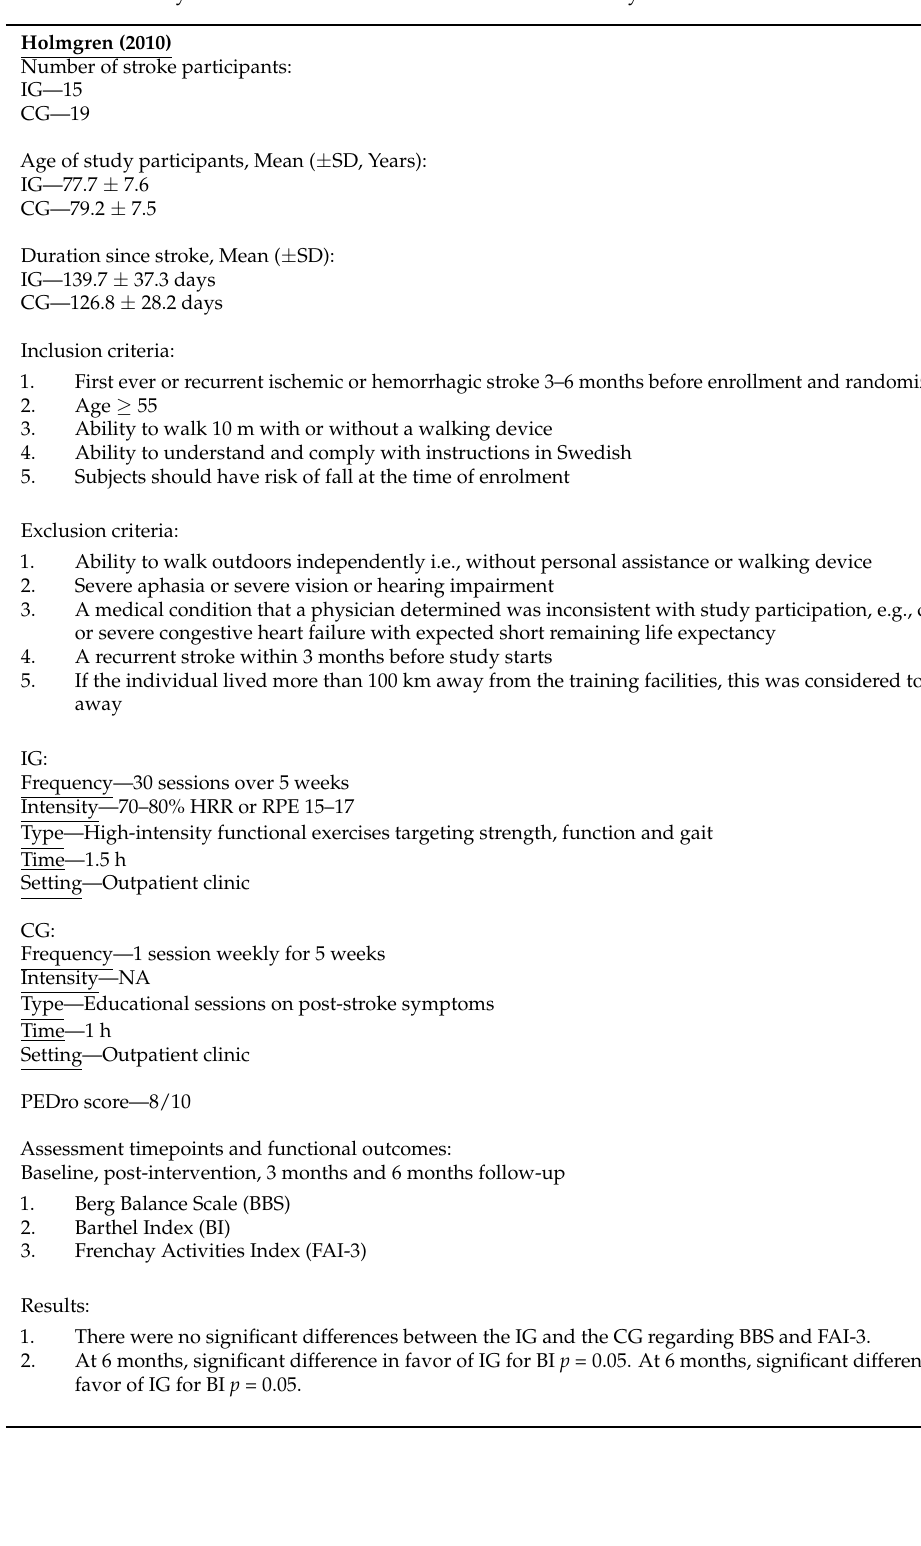
Table 1. Summary information for all included studies in this systematic